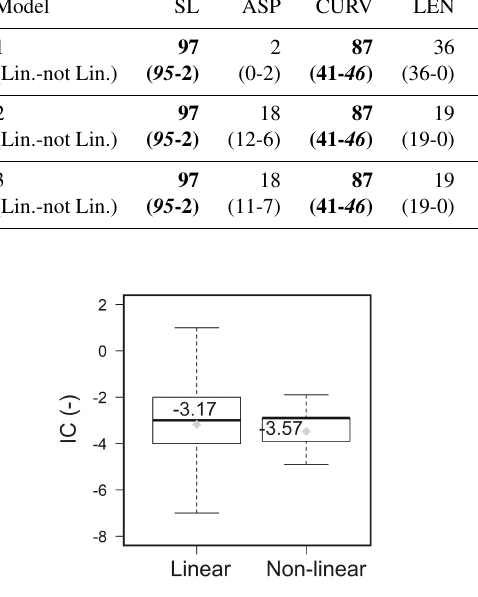
Figure 7. Box-plot of IC values distribution for the actual scenario (2015), for the linear and non-linear calculation of the